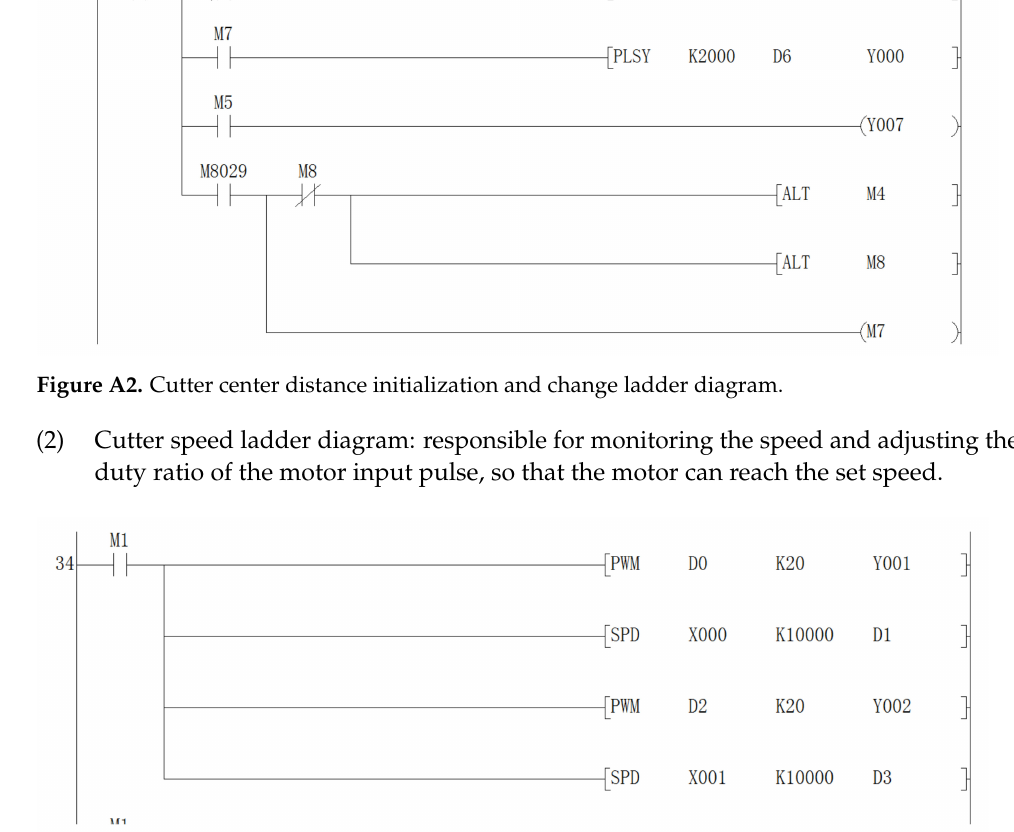
Figure A3. Cutter speed ladder diagram. (3) Ladder diagram of cutter angle change: communicate with the servo driver through the RS command, output the displacement, and make the bracket motor rotate by the specified displacement.